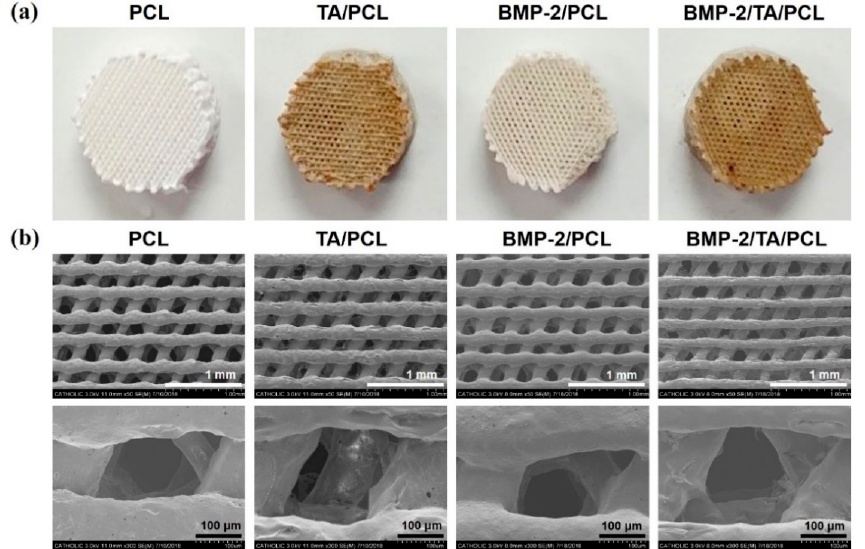
Table 1. Surface elemental compositions of PCL and modified PCL scaffolds determined by X-ray photoelectron spectroscopy (XPS).